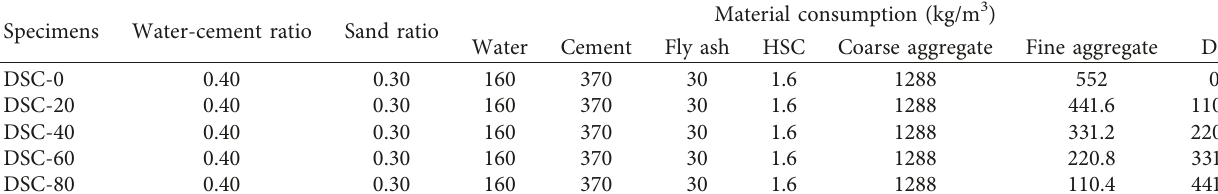
Table 3: The mix proportion of DSC.